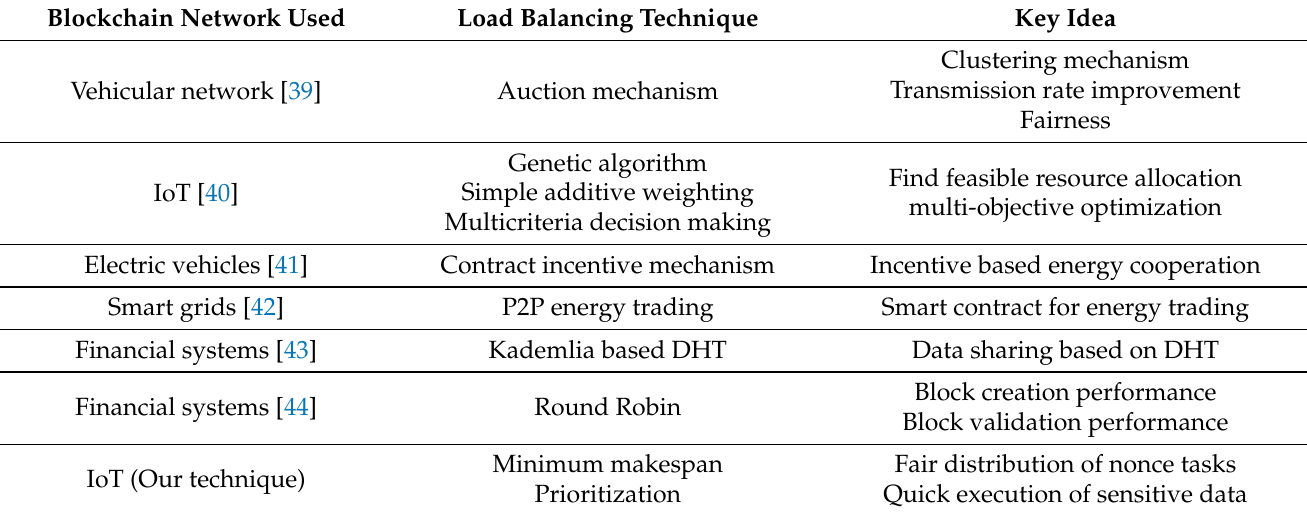
Table 1. Load balancing techniques used in